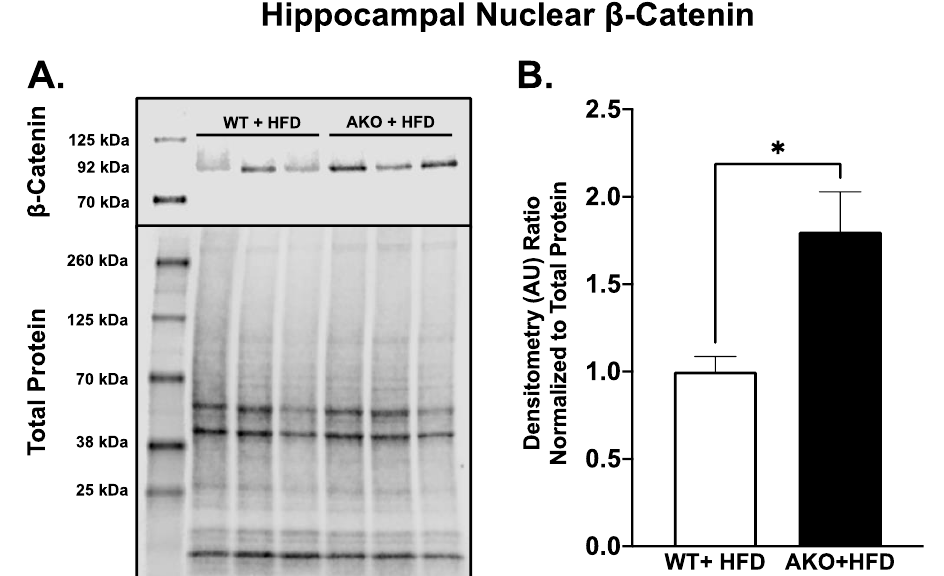
Figure 2. ( A ) Western blot of nuclear β -Catenin in HFD-fed AKO and WT mice. Licor Revert 700 total protein stain is shown below. ( B ) Densitometry normalized to total protein. Unpaired t -test, n = 3, * denotes significance of p < 0.05 ( p = 0.03).